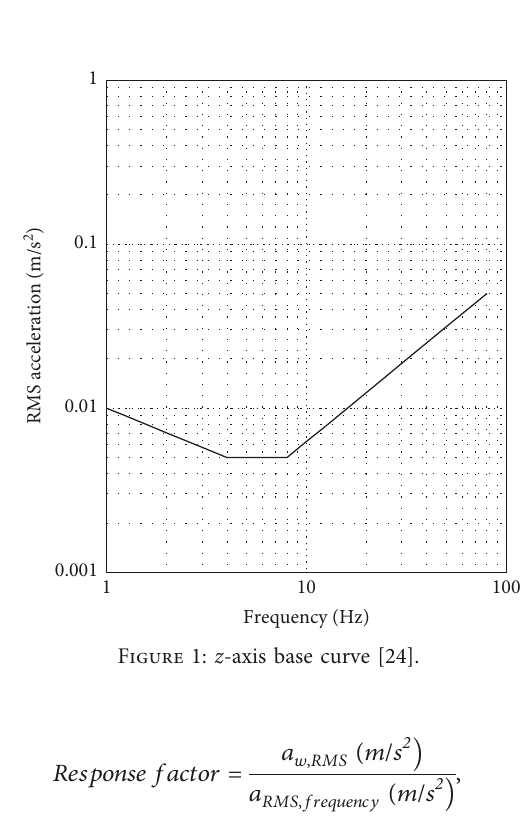
Figure 1: z -axis base curve